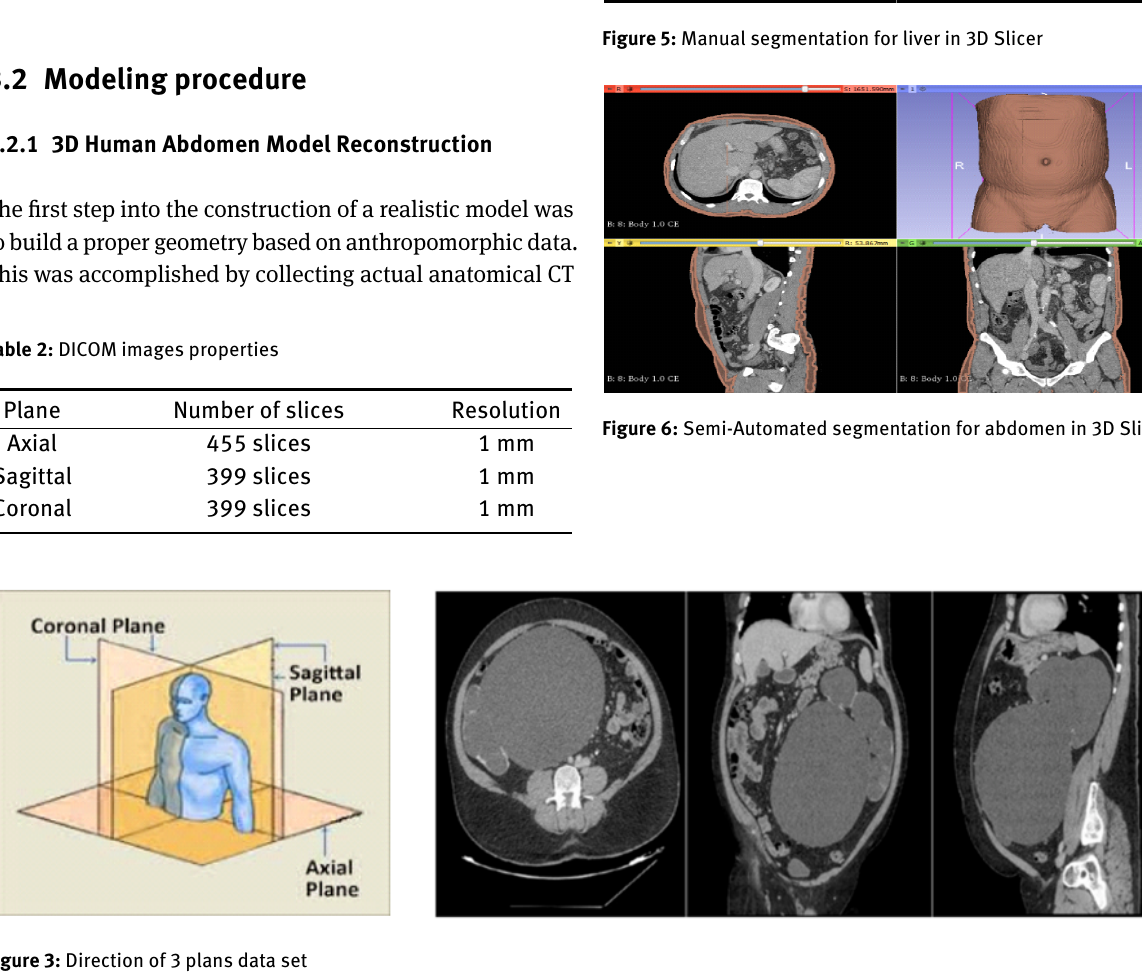
Figure 3: Direction of 3 plans data